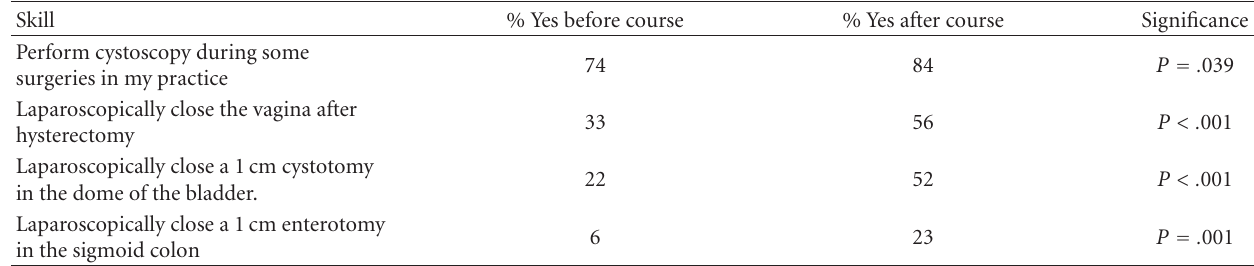
Table 2: Skill changes ∗